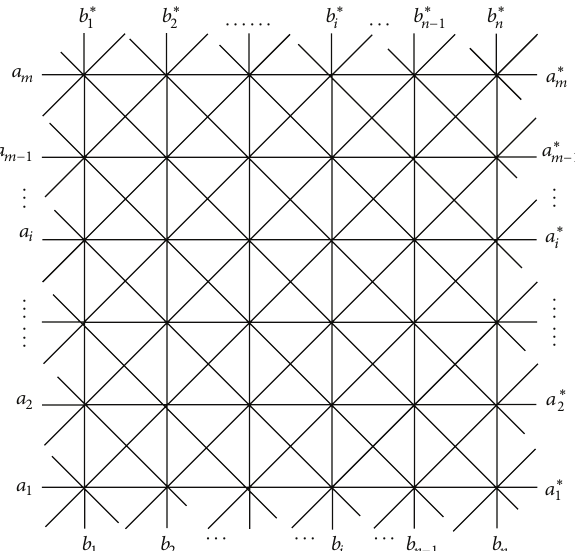
The above numerical integration value implies that 𝑆 𝑡 (𝑚, 𝑛) has the asymptotic incidence energy IE (𝑆 𝑡 (𝑚, 𝑛))